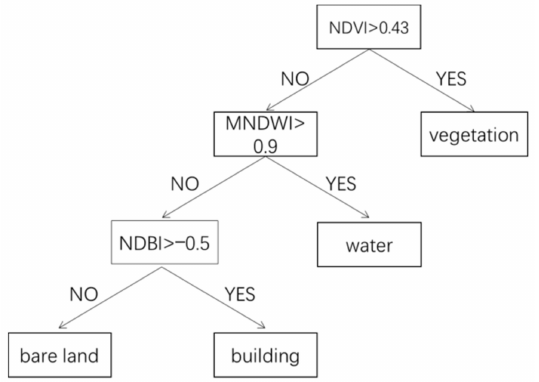
Figure 2. Land use classification and regression.